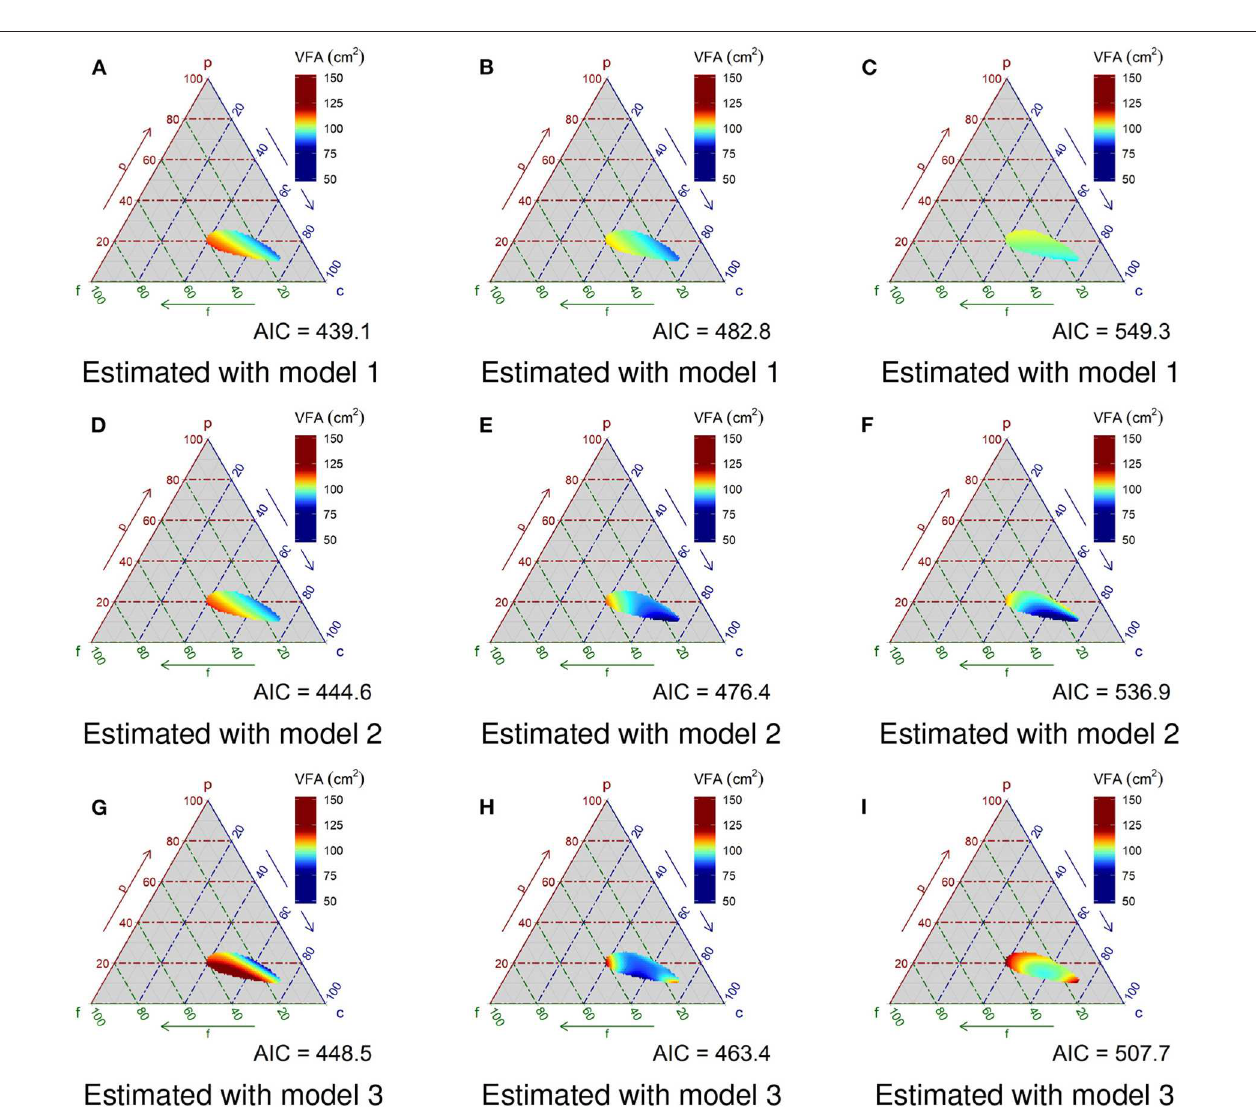
FIGURE 4 | Evaluation for reproducibility of the statistical model. (A–C) Show reproduced visceral fat areas with Model 1 for patterns A, B, and C, respectively. (D–F) Are those with Model 2, and panels (G–I) are those with Model 3. Model 1 has the transformed compositional PFC data as an explanatory variable. Model 2 has the square term of the compositional PFC in addition to Model 1. Model 3 has the interaction terms of compositional PFC and its square term in addition to Model 2.